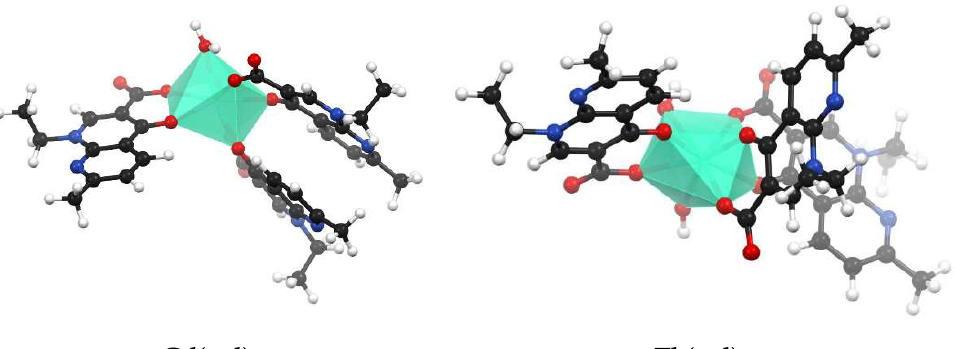
Figure 4. Optimized molecular geometries of M(nal) 2 and M(nal) 3 computed using the semiempirical method PM7 in MOPAC; the images were obtained using Mercury ® 2020.2 CSD Release (Cambridge Crystallographic Data Centre, Cambridge, UK).